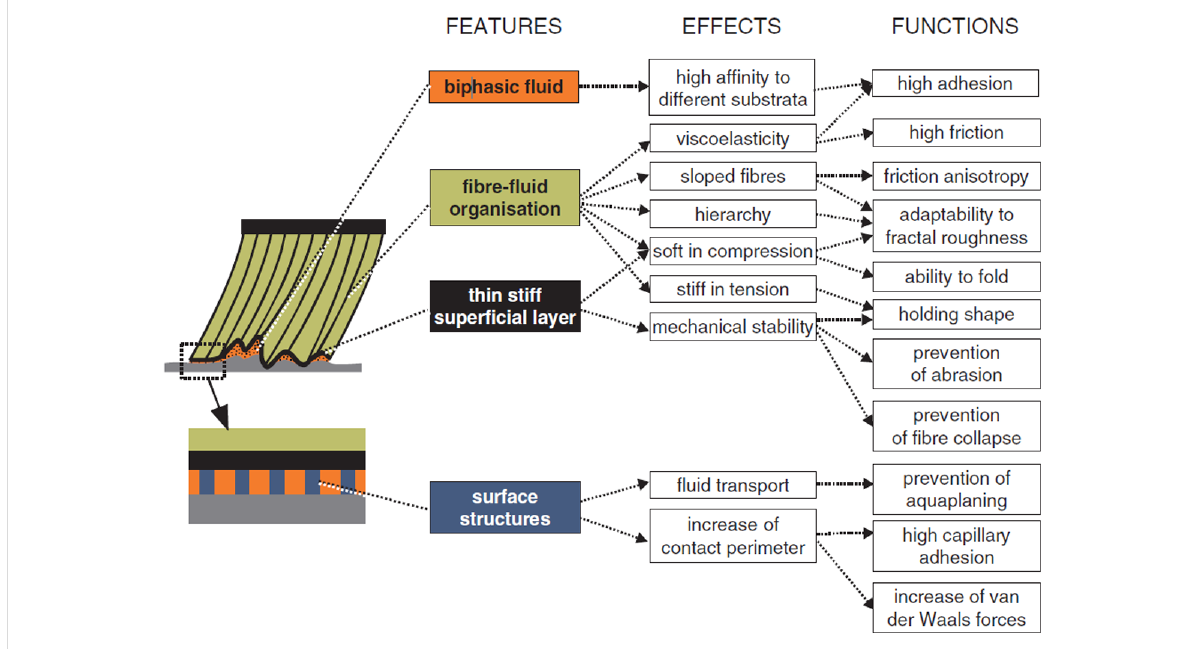
Figure 9: Diagram summarizing structural features of smooth attachment pads that evolved in a convergent matter. Those features are responsible for particular functional effects. Figure 9 was reproduced from [35], “Advances in Insect Physiology: Insect Mechanics and Control.”, 1st Edition,